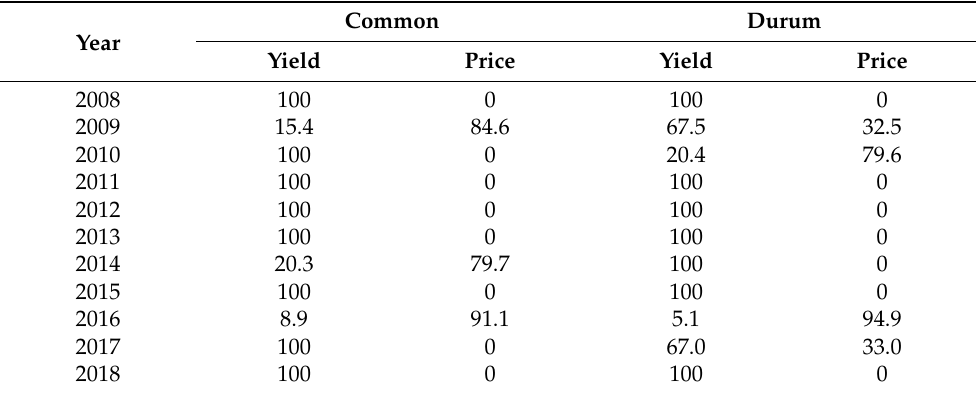
Table 5. Yield and price effect as share (%) of total hypothetical compensation. Common Durum Year Yield Price